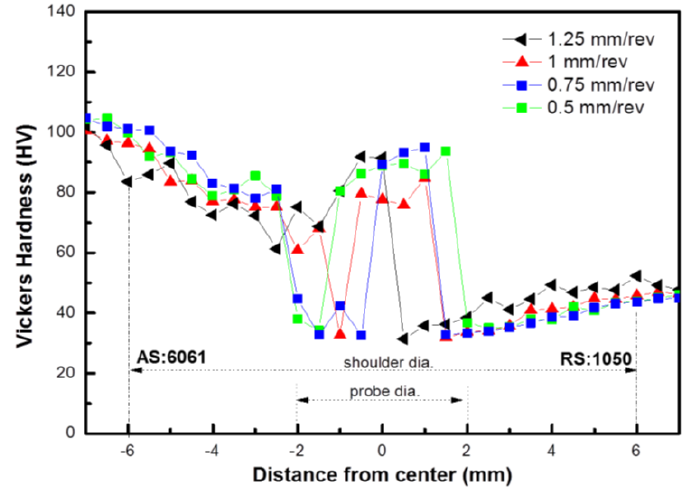
Figure 9. Hardness profile along center line of the cross-sectional plane of the dissimilar FSW joints produced at various welding speeds.